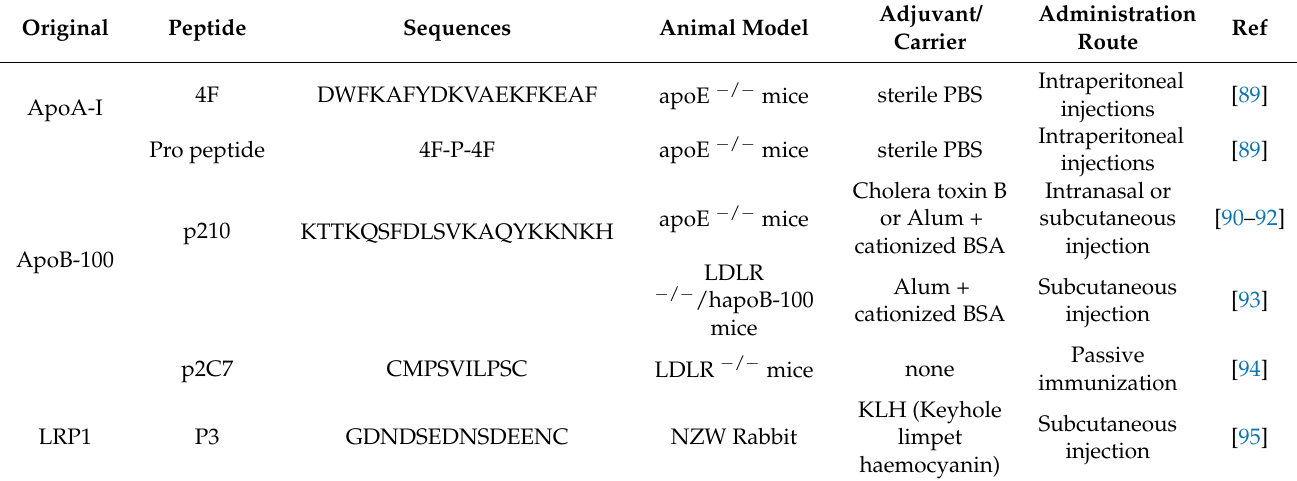
Table 2. Apolipoprotein and LRP1-based peptides used for immunization